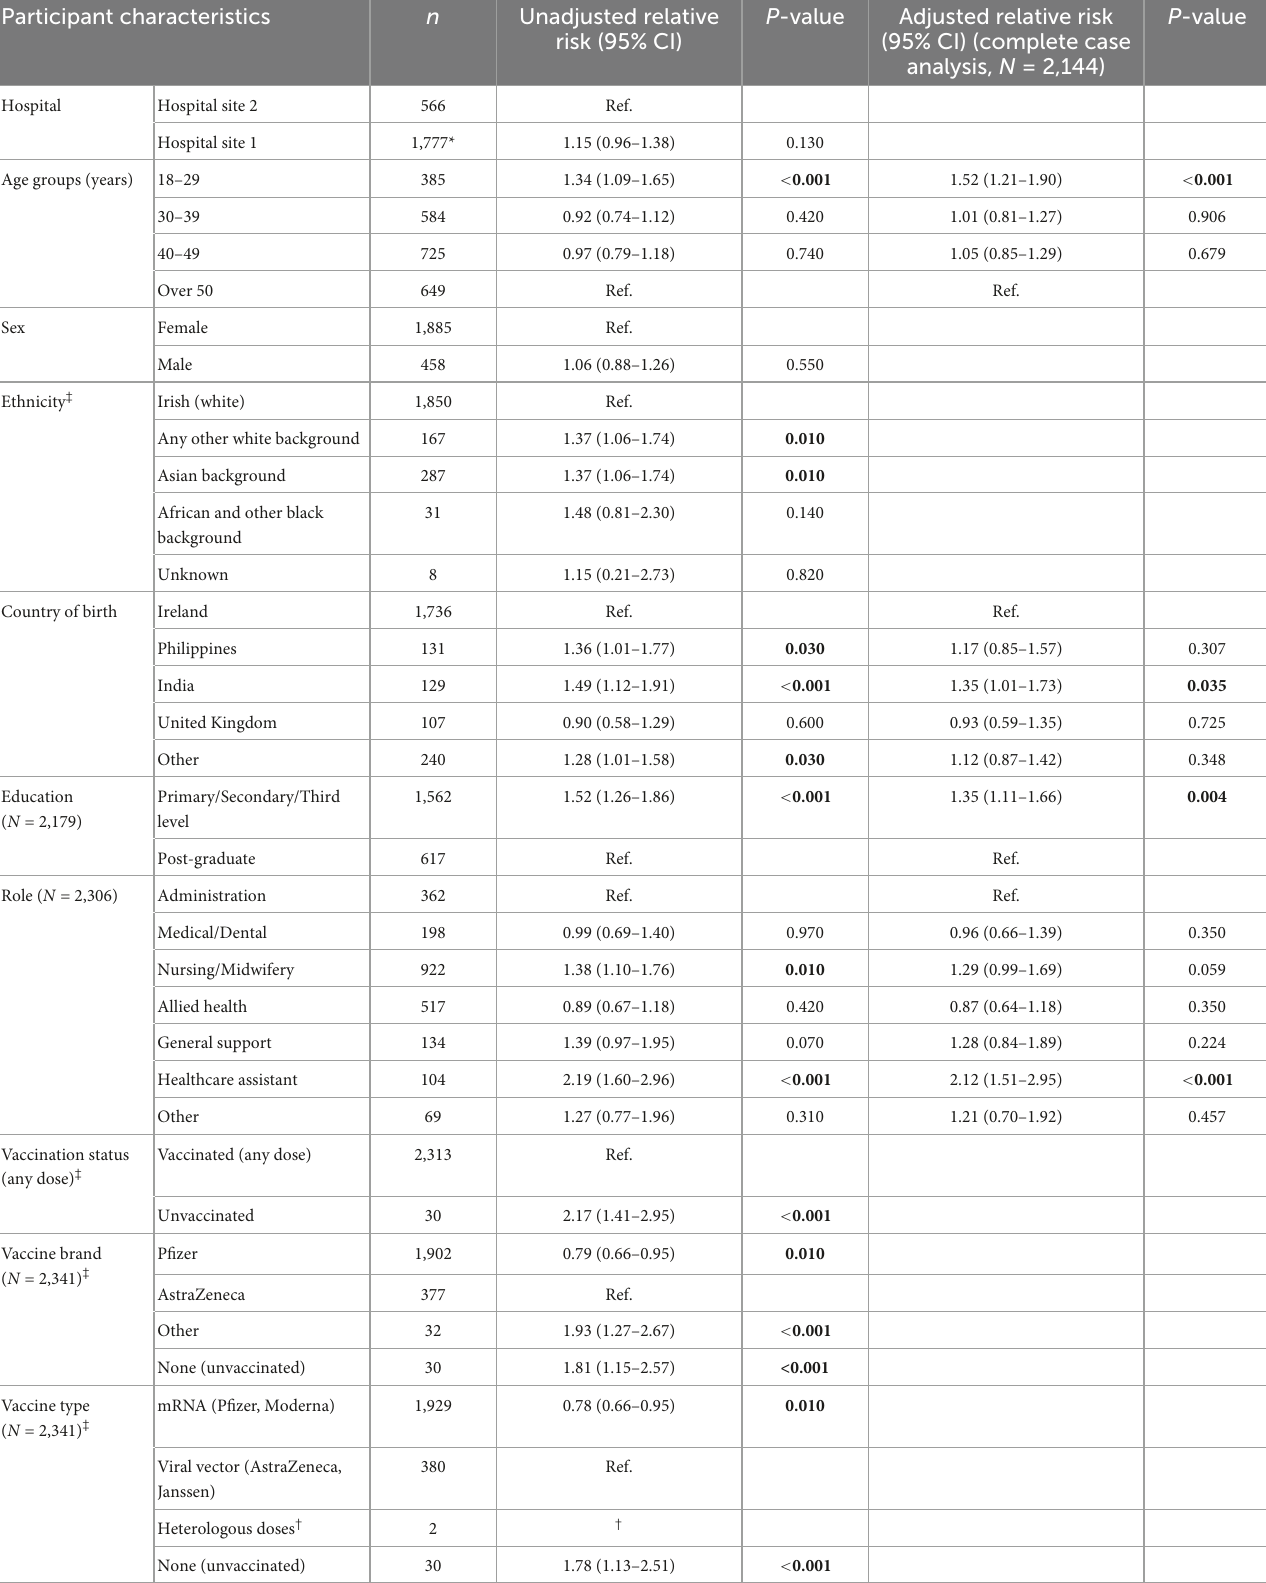
TABLE 3 Association between risk factors and SARS-CoV-2 seropositivity, PRECISE 4, Ireland, November 2021 ( N = 2,343). Participant